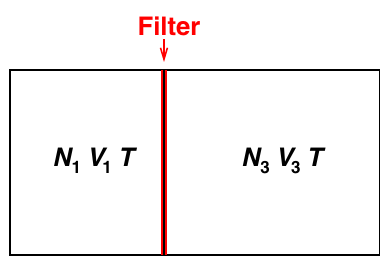
FIG. 2. Schematic plot of the AdResS system in thermody- namic equilibrium. The thickness of the filter corresponds to d (cid:1)